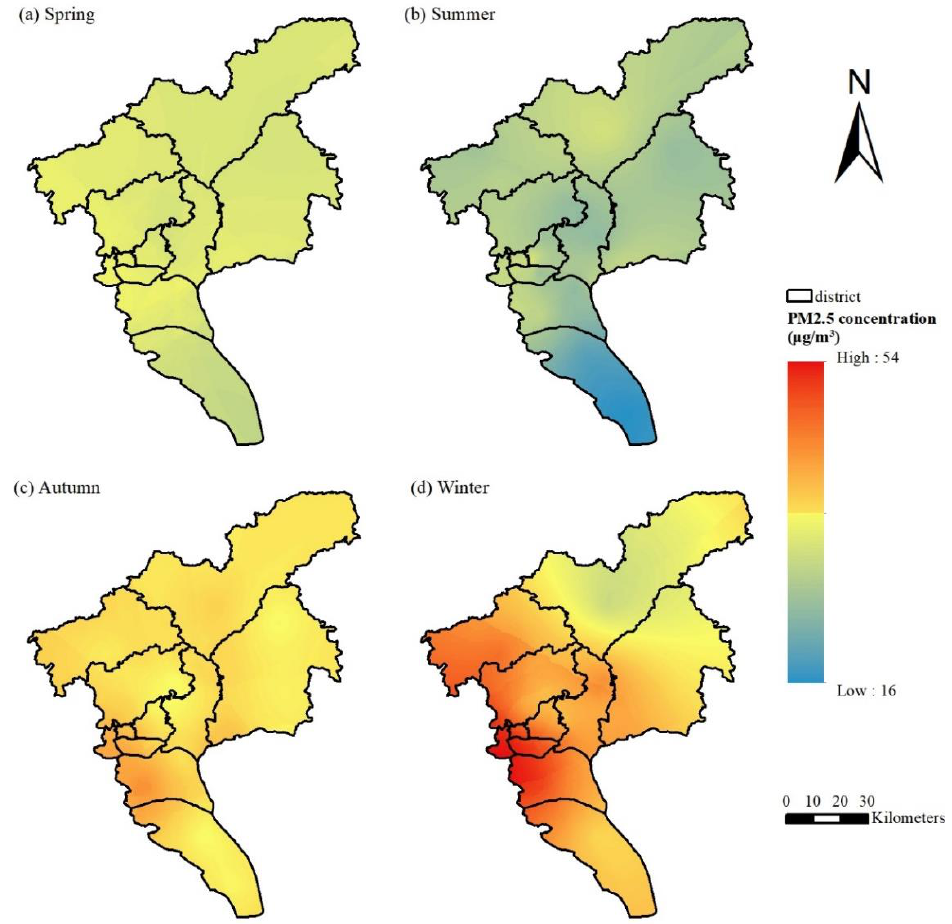
Figure 2. Spatial distribution of PM 2.5 through ordinary kriging in 2015: ( a ) spring, ( b ) summer, ( c ) autumn, ( d ) winter.